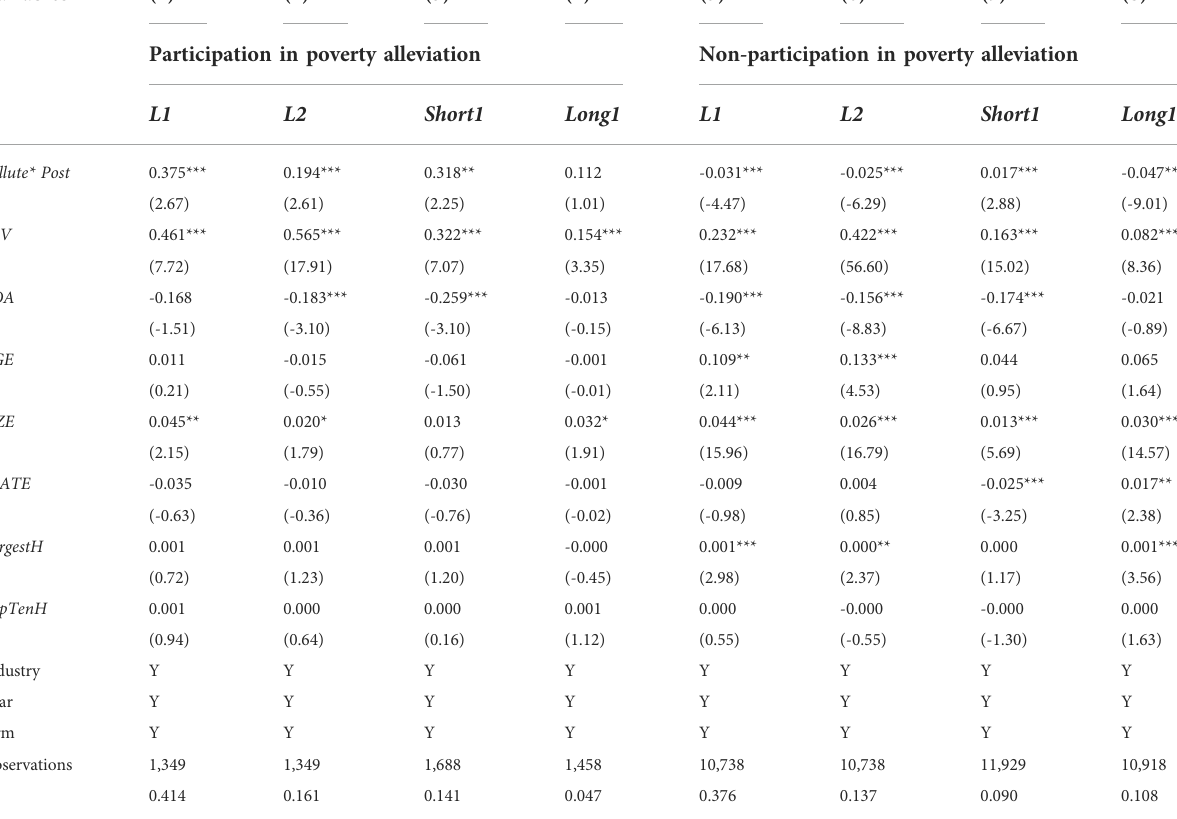
TABLE 4 Empirical results on the corporate debt for participate in poverty